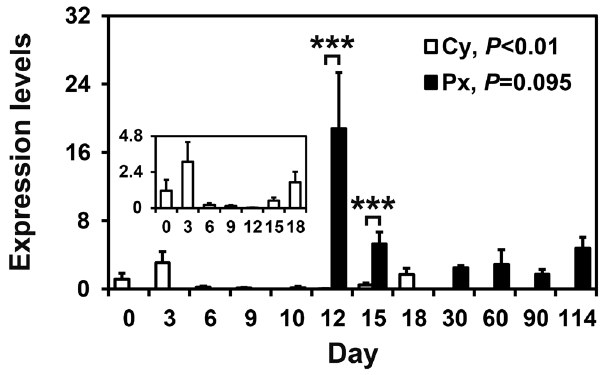
Figure 1. Expression of serum amyloid A3 ( SAA3 ) in the endometri- um during the estrous cycle and pregnancy. Endometrial tissue sam- ples from cyclic (Cy) and pregnant gilts (Px) were analyzed by re- al-time reverse transcription-polymerase chain reaction, and data are reported as expression relative to that detected on day 0 of the es- trous cycle after normalization of the transcript amount to the en- dogenous RPL7 , UBB , and TBP controls. RPL7 , ribosomal protein L7; UBB , ubiquitin B; TBP , TATA binding protein. Data are presented as mean with standard error. ***